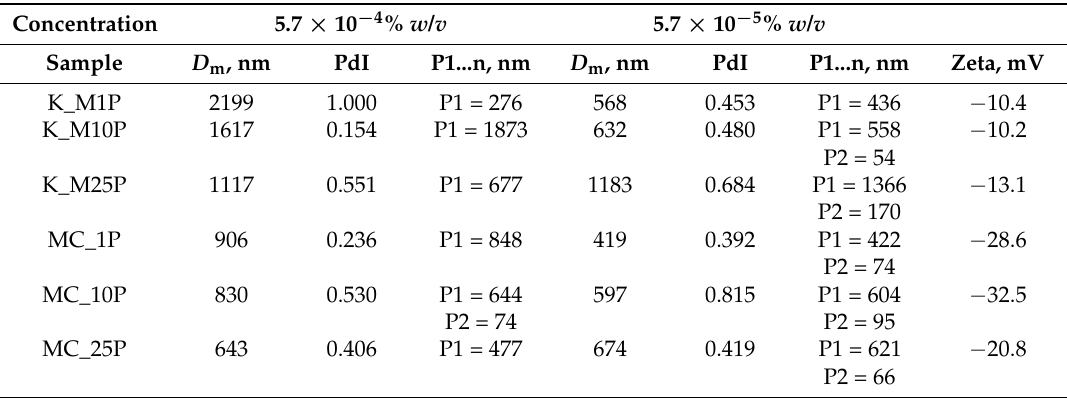
Table 2. Average diameter, polydispersity index, and Zeta potential determined by dynamic light scattering